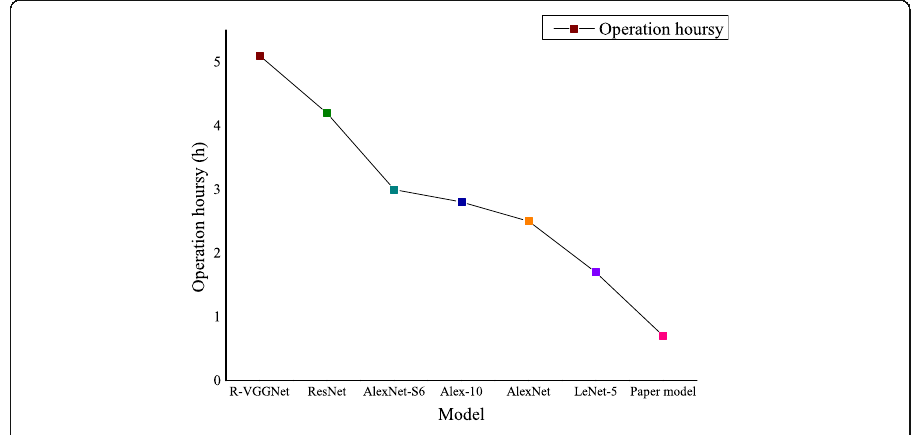
Fig. 8 Comparison of the running times of different